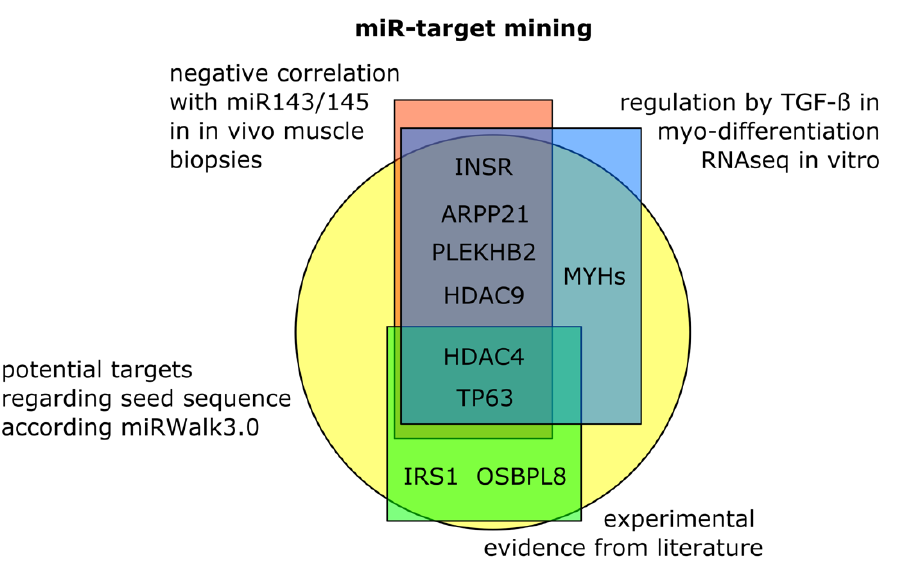
Figure 4. Target mining for potential skeletal muscle specific miR-143/145 targets. The following criteria were applied: transcripts had to contain a potential seed sequence for either miR-143-3p or miR-145-5p based on the MirWalk3.0 tool [40] (yellow circle); target candidates had to be downregulated by TGF- β1 treatment and rescued by combining TGF - β1 and inhibitor treatment in differentiating myotubes in vitro as detected by long RNASeq (blue rectangle); and potential targets had to show a negative correlation in a global correlation analysis between the changes in miR-143-3p and miR-145-5p, as well as the transcript detected by transcriptome analyses in the in vivo muscle biopsies (red rectangle). Additional targets were considered where previous experimental evidence as a target of miR-143/145 in related systems exists in the literature [31 – 33] (green rectangle).